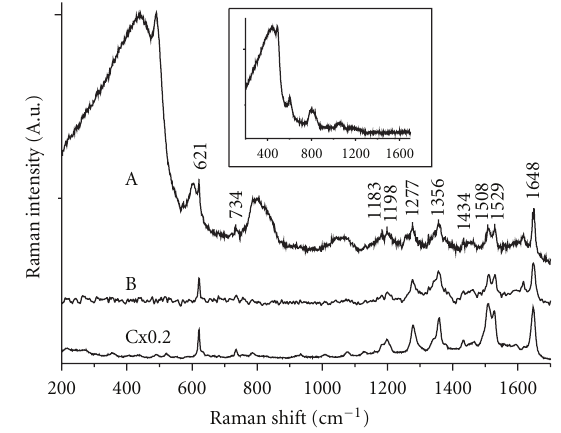
Figure 2: SERS spectra of RhB. Curve A: obtained from the measuring tip of the HCPCF probe (excitation power of ∼ 4.7 mW, scan time of 20s, and accumulation time of 5). Curve B: a smoothed subtraction between curve A and the HCPCF background (inset). Curve C: obtained using a SERS substrate coated on a Si wafer (excitation power of ∼ 0.47mW, scantime of 20s, and accumulation time of